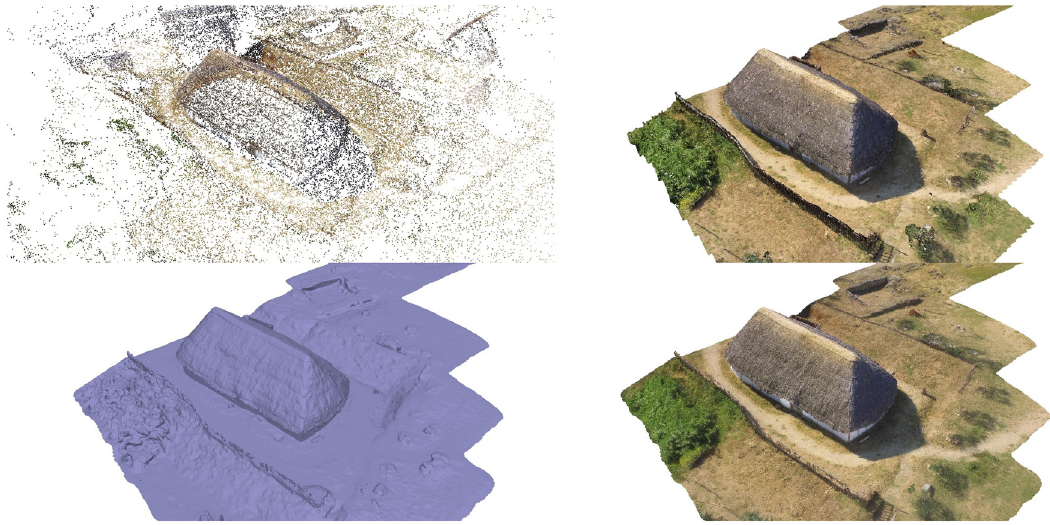
Figure 4: Photogrammetric survey of the open - air